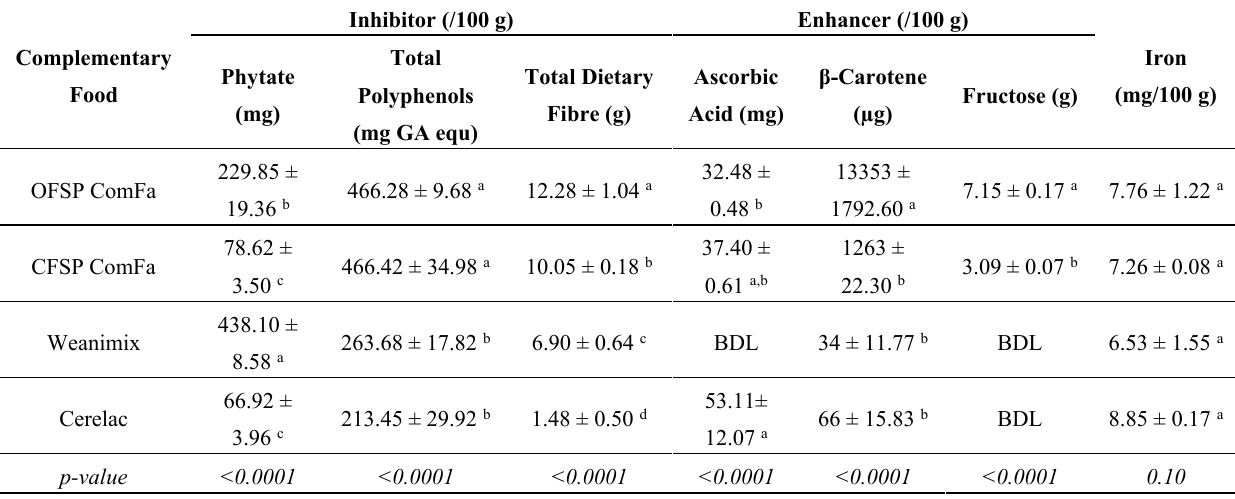
Table 1. Amount of inhibitors and enhancers of iron absorption, and the concentration of iron in sweet potato- and cereal-based complementary foods ¶